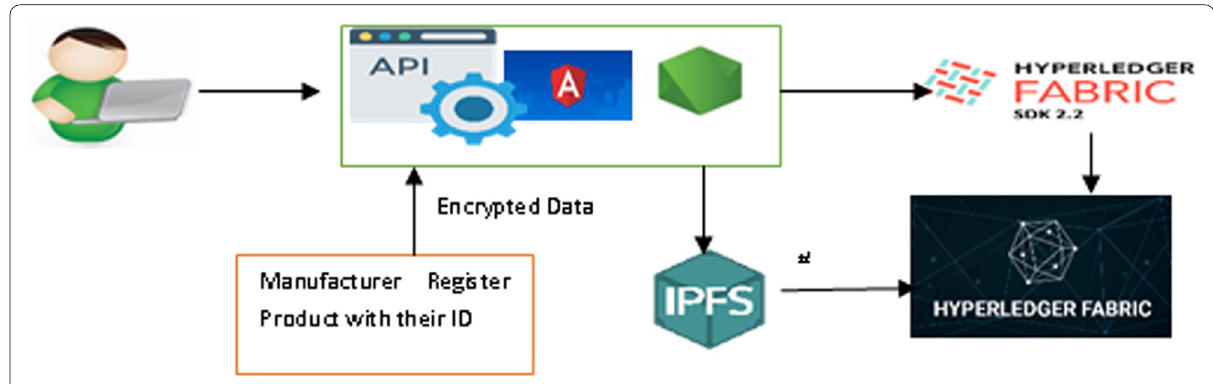
Fig. 5 Data Flow from User to